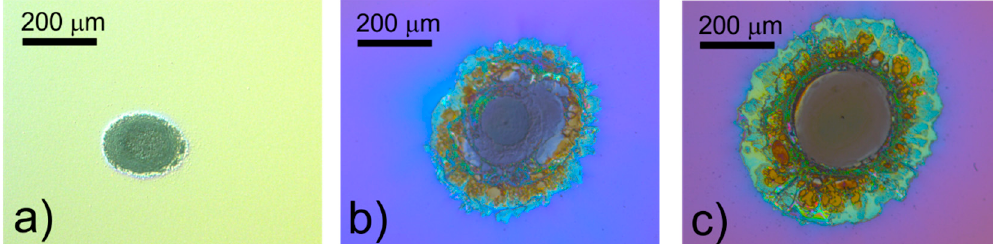
Figure 7. Typical microscopic pictures of damage sites of ( a ) a sample cleaned without adjusting the power of 80 and 120 kHz (A-CP3, 7 J/cm 2 ), ( b ) a sample cleaned using only 40 kHz (B-CP1, 52 J/cm 2 ) and for comparison ( c ) a sample with adjusted power at 80 and 120 kHz and additional 500 kHz during fine rinsing (B-CP4, 70 J/cm 2 ).